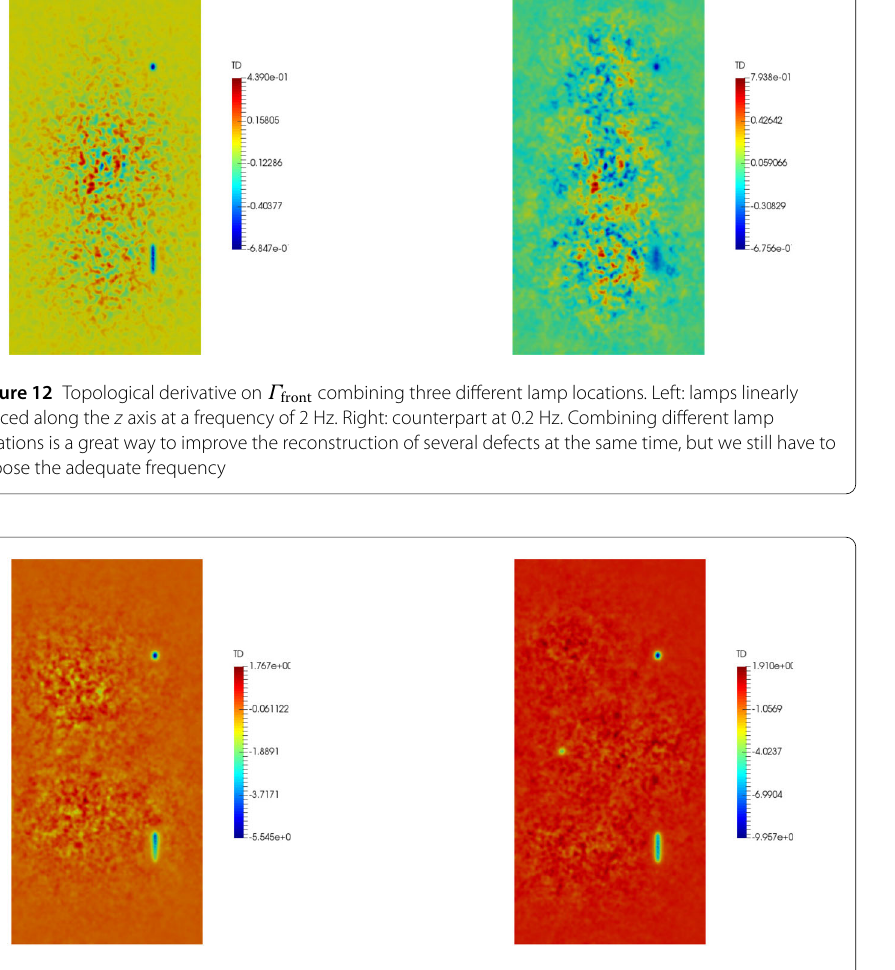
Figure 13 Topological derivative on Γ front combining several frequencies and lamp locations. Left: topological derivative corresponding to six linearly spaced frequencies between 0.2 and 2 Hz and a 2-by-2 grid of lamps. Right: counterpart when a 3-by-3 grid of lamps is used. The appearance of spurious minima is highly reduced in both cases due to the multifrequency character, and increasing the number of lamps highly improves the